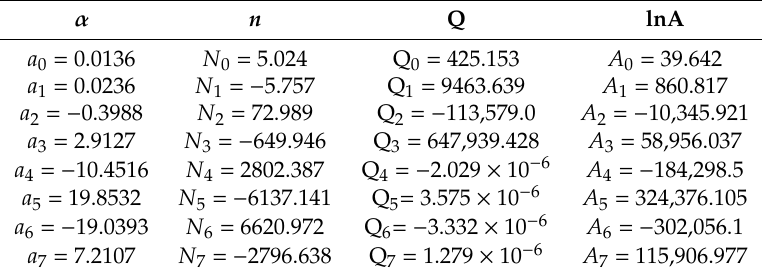
Figure 5. Variation of ( a ) α ; ( b ) n ; ( c ) lnA; ( d ) Q with true strain represented by a 7th order of the polynomial. Table 1. Coefficients of the polynomial for α , n , Q and lnA.